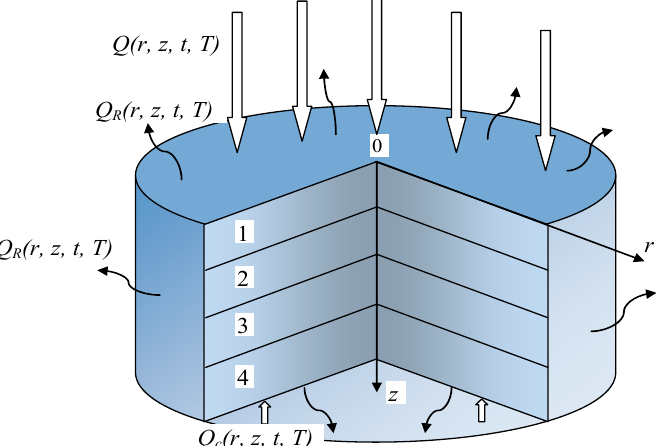
Figure 3. Calculation model.